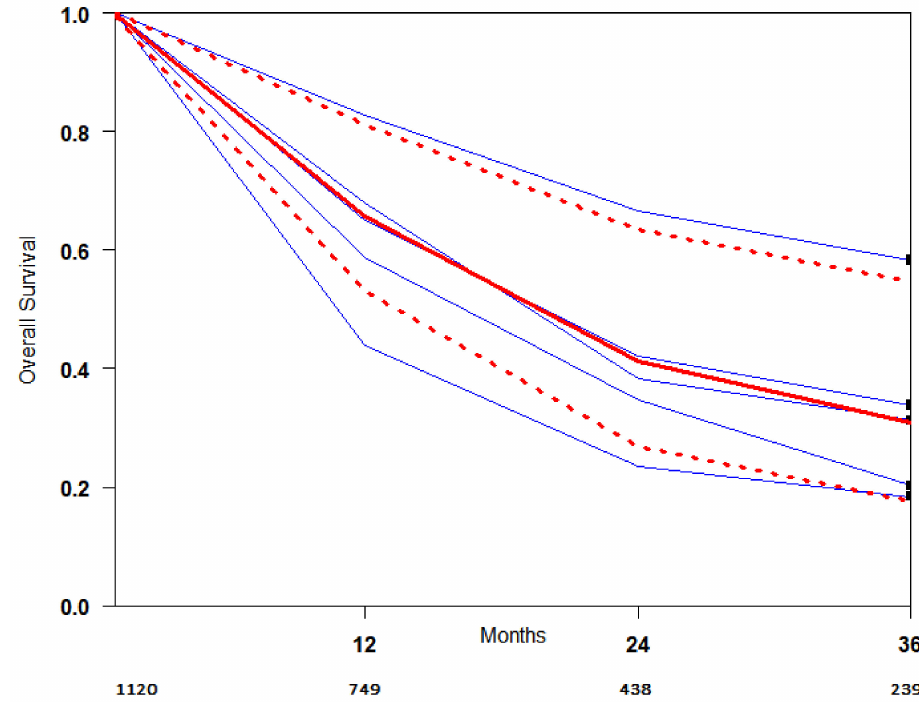
Figure 4. OS curve of studies included in the meta-analysis. Blue lines represent survival curves for each study. The red thick line represents the summarized survival curve with the 95% confidence bands (dashed lines) obtained using the approach of Combescure et al. with random effects.